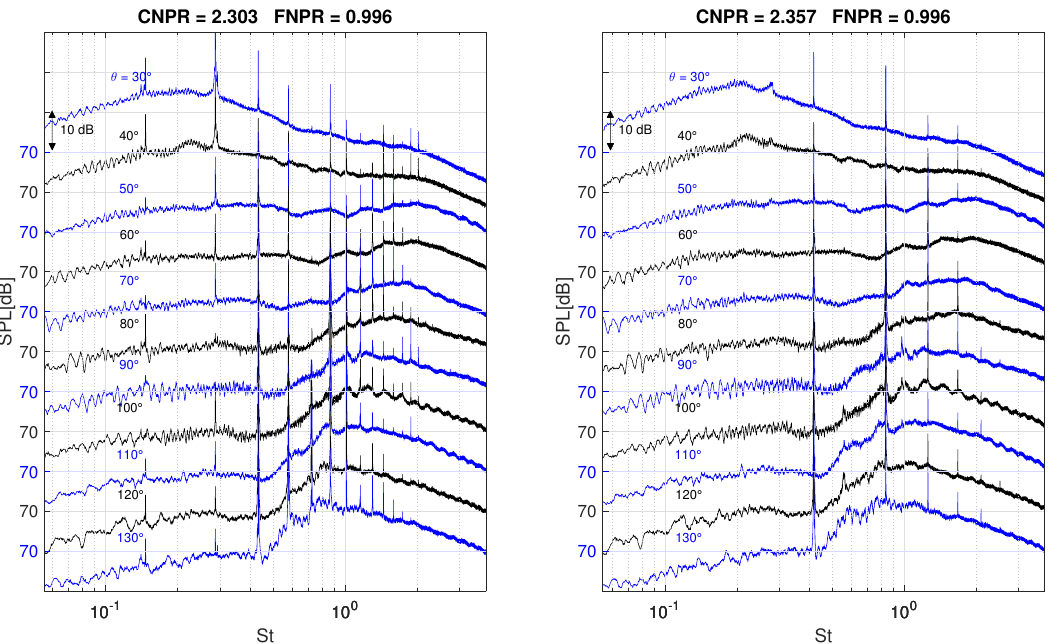
Figure 25. SPL (reference 2 × 10 − 5 Pa) at r / D 1 = 40 for CNPR = 2.30 M j = 1.16 ( left ), CNPR = 2.36 M j = 1.18 ( right ), at all the measured angles; nozzle diameter D 1 = 0.0192 m. For Nozzle Set 2, the switching from the axisymmetric mode to the flapping mode occurs at higher CNPR compared to Nozzle Set